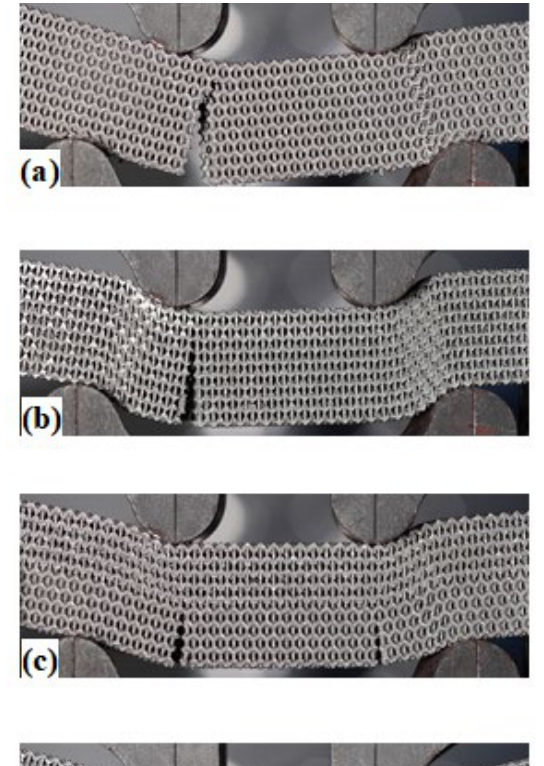
Figure 11. The load–displacement curves of the PPR, NPR, HPR and FGHPR lattice beam samples tested under four-point bending.